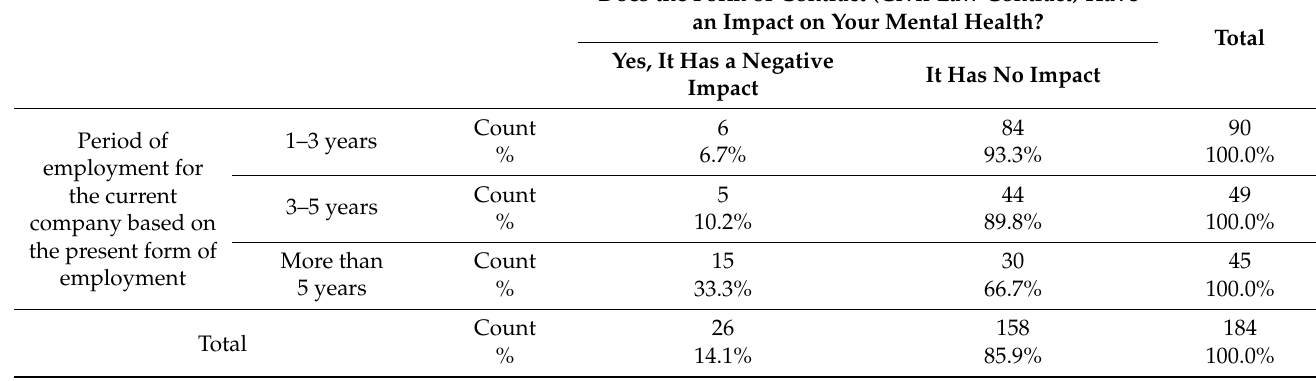
Table 4. The frequency of responses regarding the impact of the form of employment on workers’ mental health based on the criterion of the length of service.